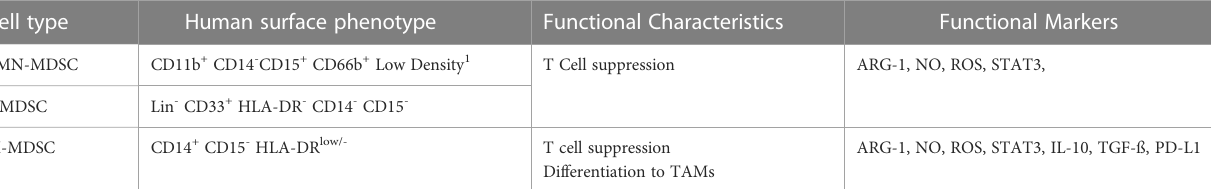
TABLE 1 Phenotype and functional markers by MDSC